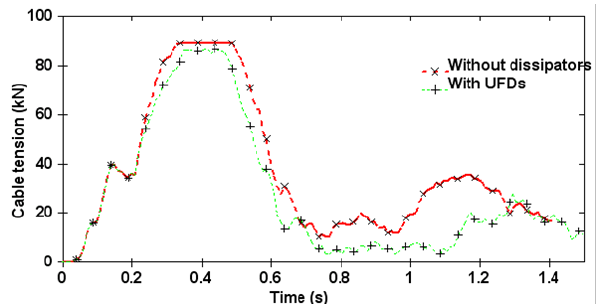
Figure 11 Numerically simulated evolution of maximum tension in the cable (at location M in 2 Fig. 11. Numerically simulated evolution of maximum tension in Fig. 1) with and without UFDs integrated into the system, subjected to the same impact 3 the cable (at location M in Fig. 1) with and without UFDs integrated energy of 150 kJ. 4 into the system, subjected to the same impact energy of 150kJ.